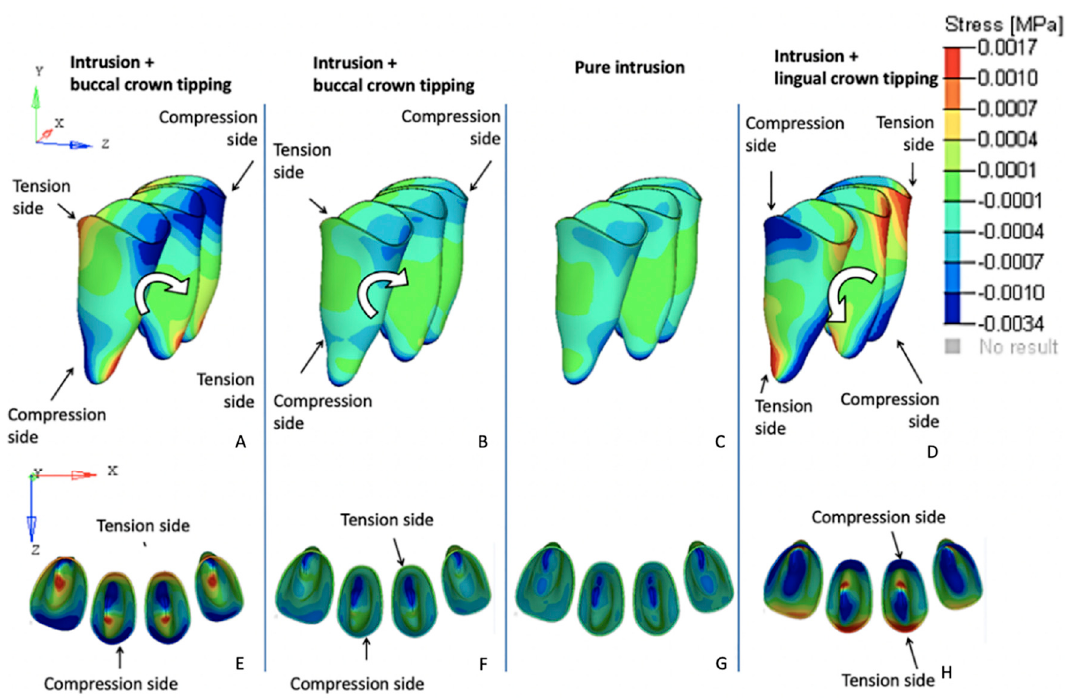
Figure 5. Von Misses stress of the mandibular incisors under 40 g of intrusive force in a sagittal ( A , B , C and D ) and occlusal ( E , F , G and H ) views. ( A ) and ( E ) FEM 1, ( B ) and ( F ) FEM 2, ( C ) and ( G ) FEM 3, and ( D ) and ( H ) FEM 4.